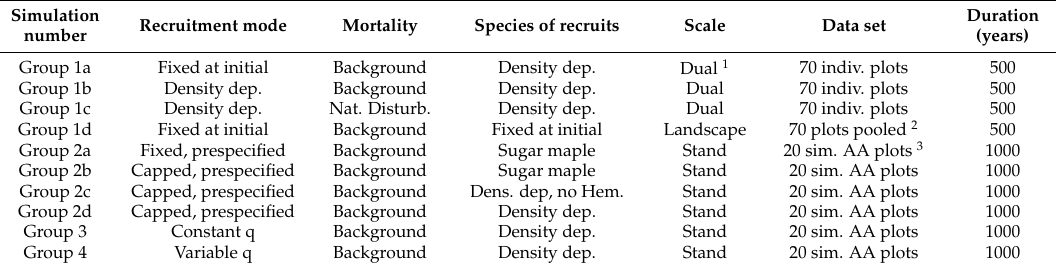
Table 1. Details of simulation